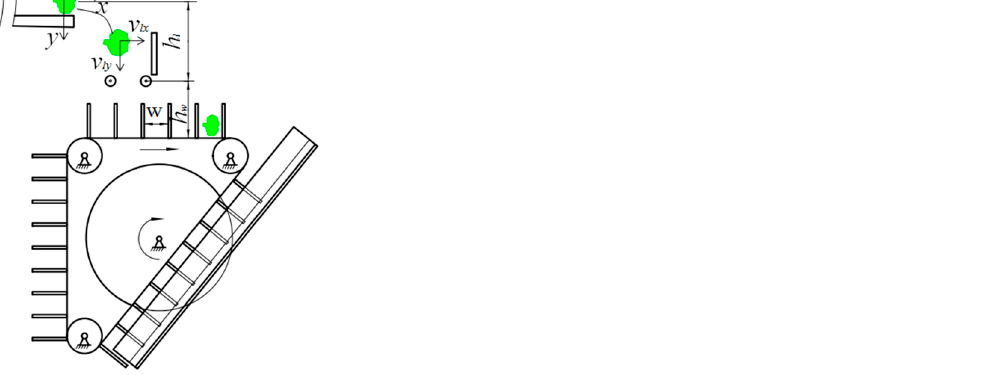
Figure 13. Schematic diagram of the process of the blocks falling into the double-baffle conveyor belt. The time ( t l ) for the block to move from the conveyor to the spiral rods and the